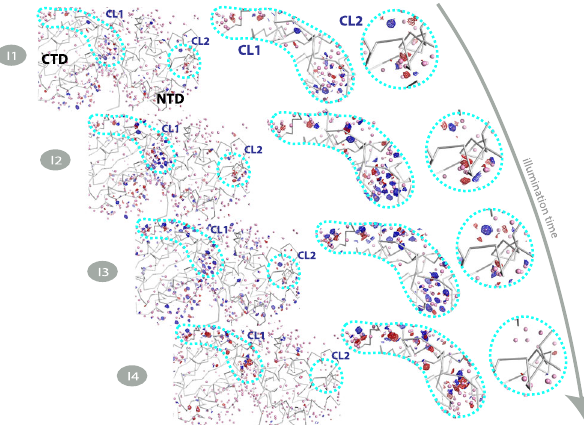
Fig. 7 | Light-driven water molecules redistribution in the OCP crystal struc- tures. Q-weightedDED mapsassociatedwith the fourpairsI1, I2,I3,and I4(in blue and red, contoured at ±3.0 σ ). Amino acids are represented by grey ribbons,